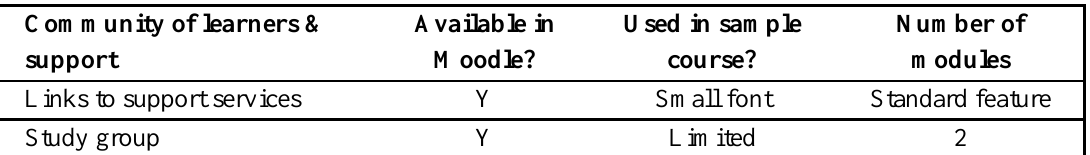
Availability of Moodle Modules Serving the Community of Learners and Support Principle Community of learners &